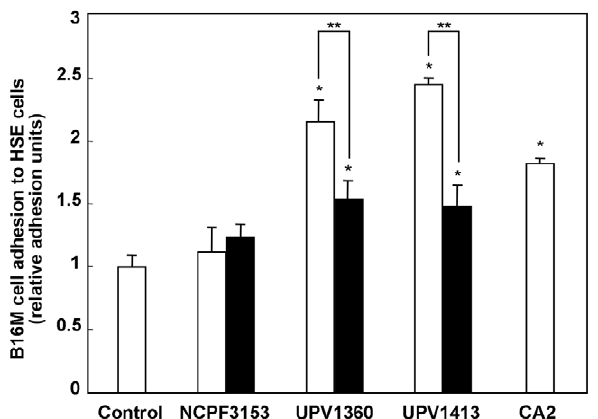
Figure 1. Effect of morphology of the different strains of Candidaalbicans on the increase in B16 melanoma ( B16M ) cell adhesion to hepatic sinusoidal endothelial ( HSE ) cells. Blas- toconidia ( % ) and germ tubes ( & ). The results shown correspond to the mean 6 SD of three independent experiments. Statistically significant differences with respect to the control or between different morphologies are indicated by one (*) and two asterisks (**) (p , 0.05),